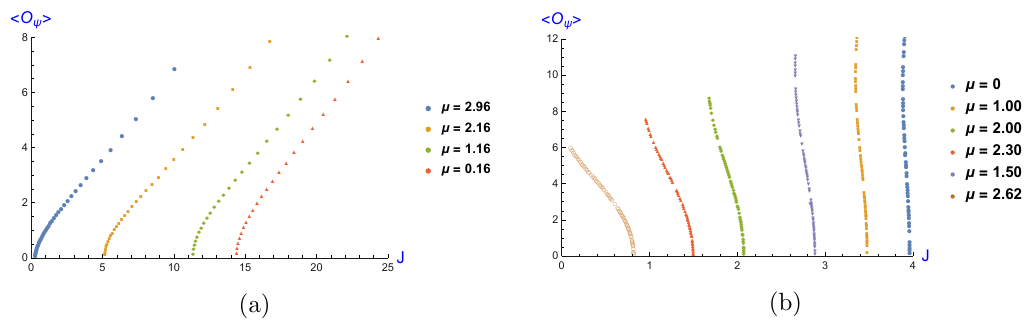
Figure 3. Plots for h O i and J as we vary the chemical potential at (cid:12)xed values of mutual interaction. In (a) we have taken (cid:11) 1 = 1 = (cid:11) 2 , (cid:21) = 0, (cid:12) = 0 : 6, and (cid:22) has been varied from 0.16 to 2.96. In (b), we have taken (cid:11) 1 = 0 : 1 = (cid:11) 2 , (cid:12) = 0, (cid:21) = 0 : 66 and (cid:22) has been varied from 0 to